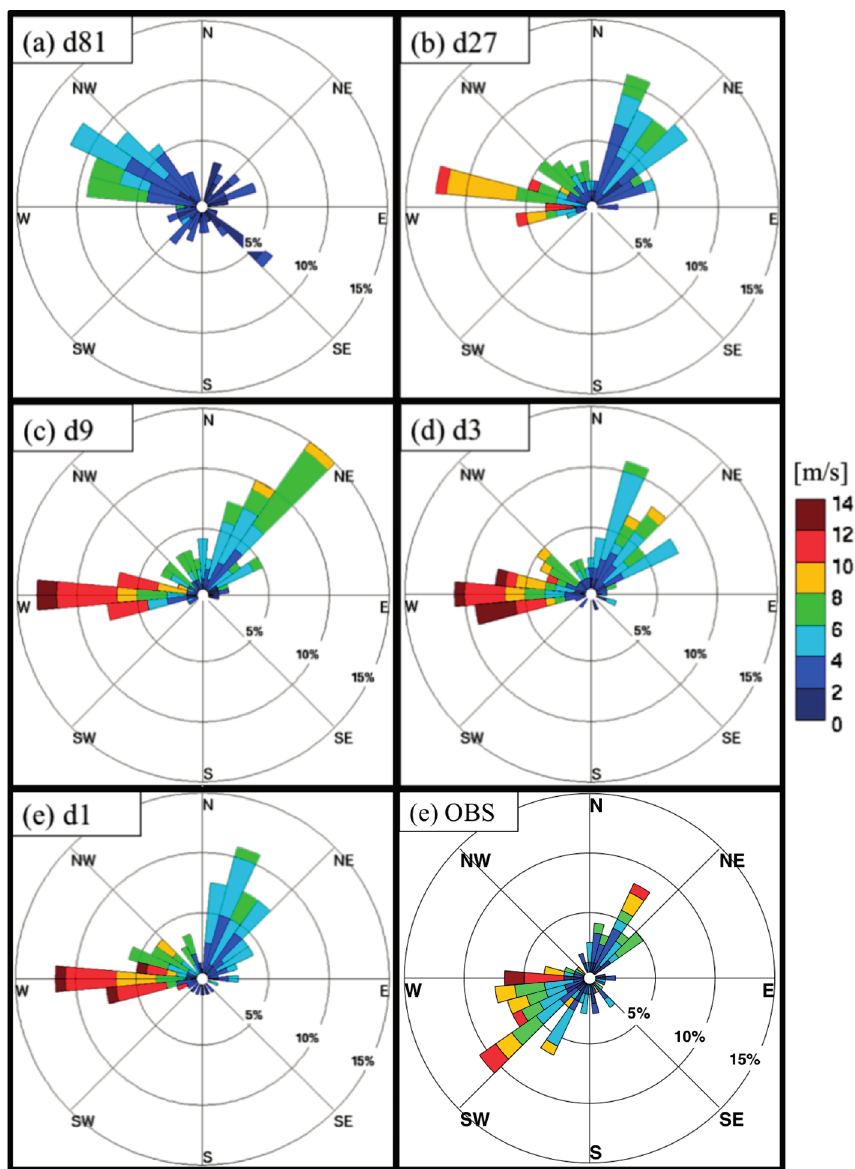
Figure 6. ( a – d ) Same as Figure 5, but at the grid point closest to Montréal (red dot in Figure 1) and averaged over the period from 0000 UTC 13 February to 0000 UTC 1 March 2002. ( e ) Same Figure 5, but for the Pierre-Elliott-Trudeau Airport surface station (© [76]) from the Environment Canada